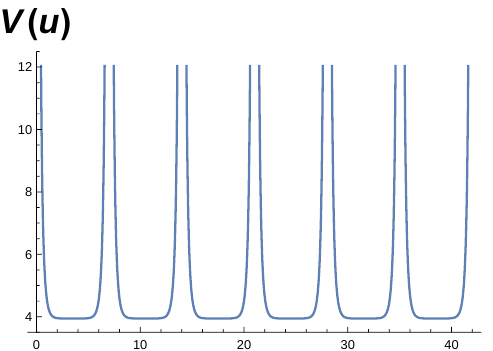
Figure 4. Plot of the potential V ( u ) for more than one period